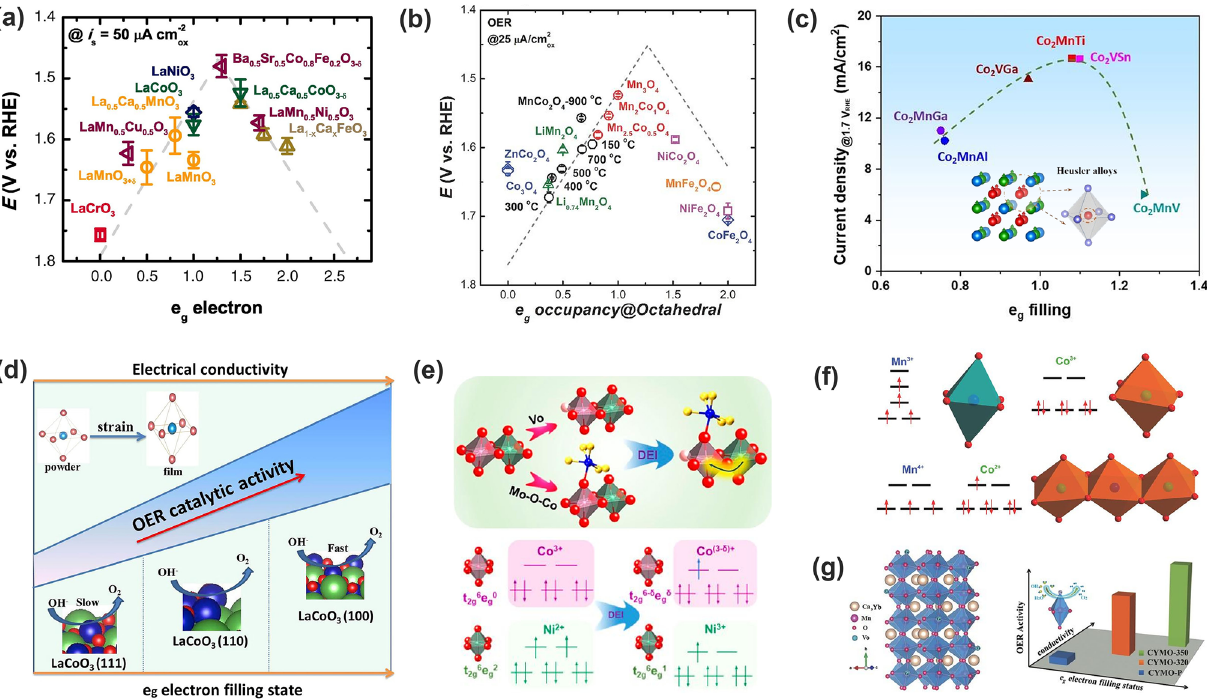
Fig. 6 Correlation between e g occupancy and OER activity of TMOs, and strategies to regulate the e g occupancy. OER activity as a function of eg occupancy of the active center at octahedral site on a perovskite oxides [63], b spinel oxides [65], and c Heusler alloys [70], respectively.